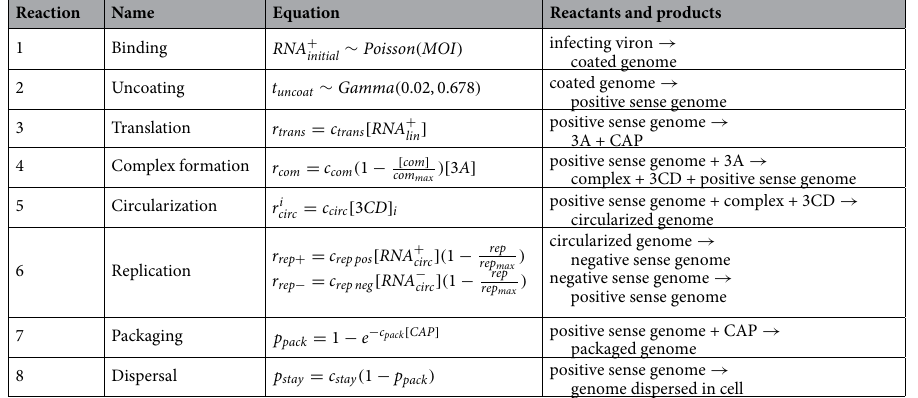
Table 1. The reactions that describe the replication cycle of PV. Numbered steps correspond to individually modeled reactions as described in Fig. 2. See Schulte et al. 23 for a full mathematical description of the